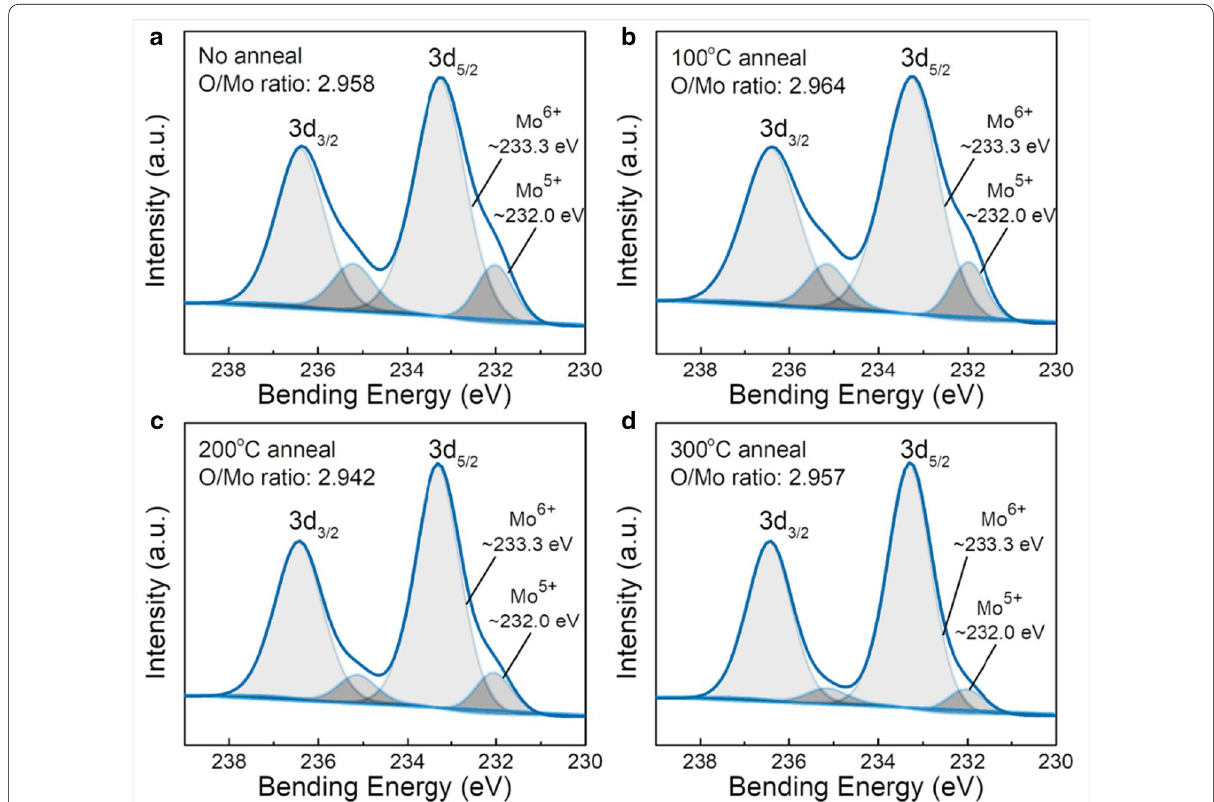
Fig. 3 Mo 3d core-level XPS spectra of the 10-nm-thick MoO X films on silicon wafers a without post-annealing, with post-annealing at b 100 °C, c 200 °C and d 300